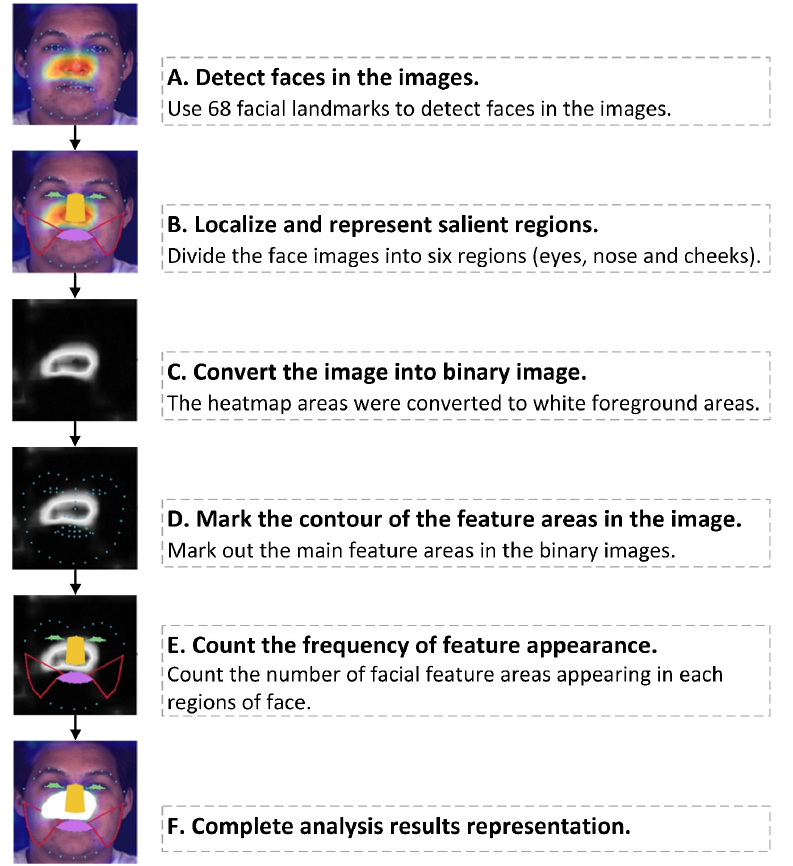
Figure 4. The quantitative facial feature analysis process. Note: The picture is for demonstration purposes only. The person in the picture has no connection with any use of illicit drugs. The data are from the BP4D dataset [35,36].